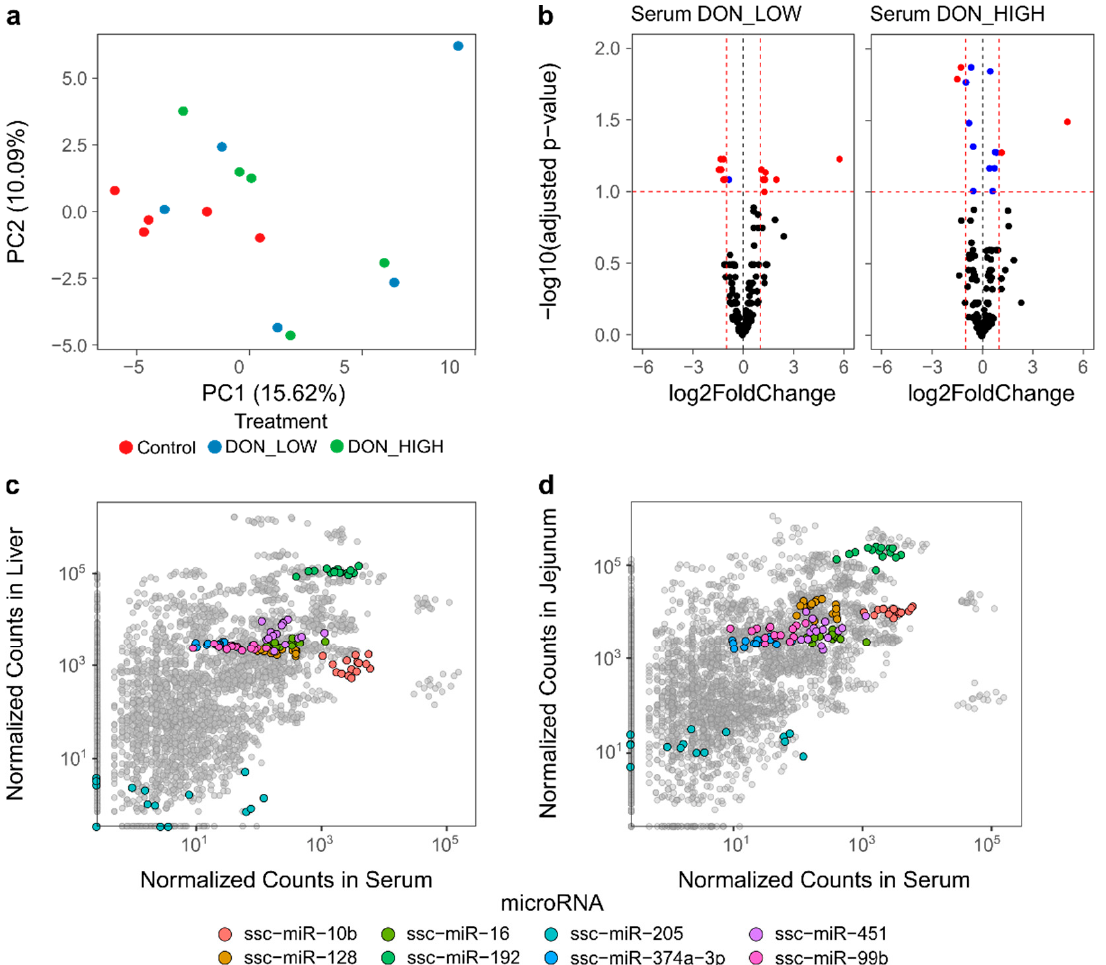
Figure 3. MicroRNA abundance in serum samples based on sequencing data. ( a ) Principal component analysis based on microRNA abundance in the serum samples; ( b ) volcano plots of differentially expressed genes showing the fold changes and FDR (adjusted p -values) of microRNAs in the DON_LOW and DON_HIGH samples compared to Controls. Red dots: microRNAs with FDR < 10% and > 2-fold change; blue dots: microRNAs with FDR < 10%; ( c ) normalized counts in liver and serum for all microRNAs in all analyzed samples; ( d ) normalized counts in jejunum and serum for all microRNAs in all samples. The eight selected microRNAs found in liver as well as in jejunum are highlighted. Each dot represents the abundance of a microRNA in a specific sample.